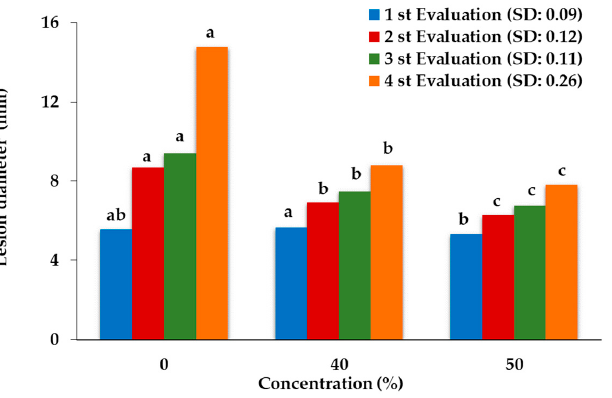
Figure 7. Effect of preventive application of ethanolic extracts of Dipteryx punctata and of the coumarin pattern on the diameter of the lesions, in the four evaluations carried out during the test. Means followed by the same lowercase letters in the columns do not differ from each other by Tukey’s test ( ≤ 0.05). SD = standard deviation.